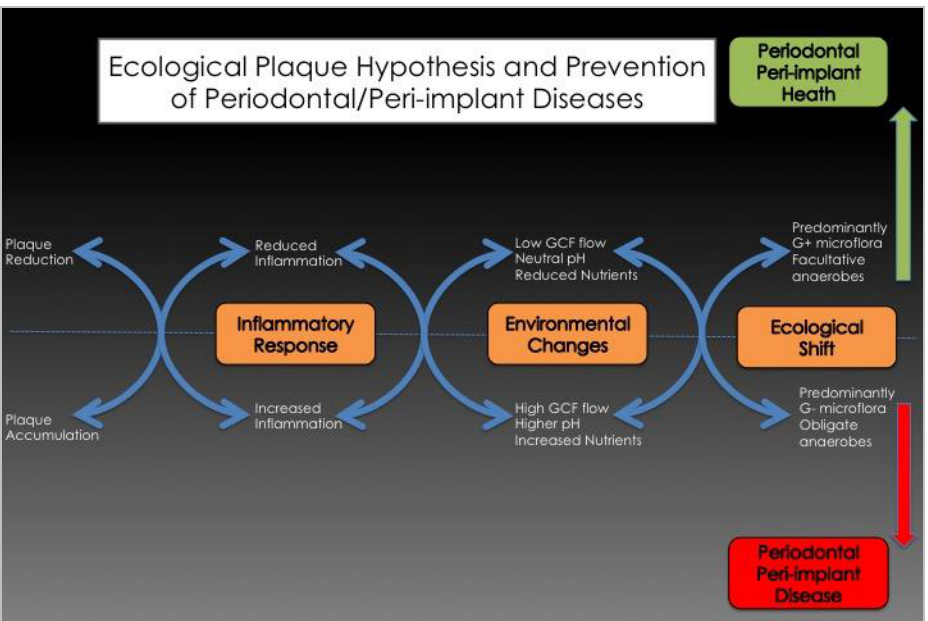
Figure 3. The ecological plaque hypothesis (Adapted from [69]).